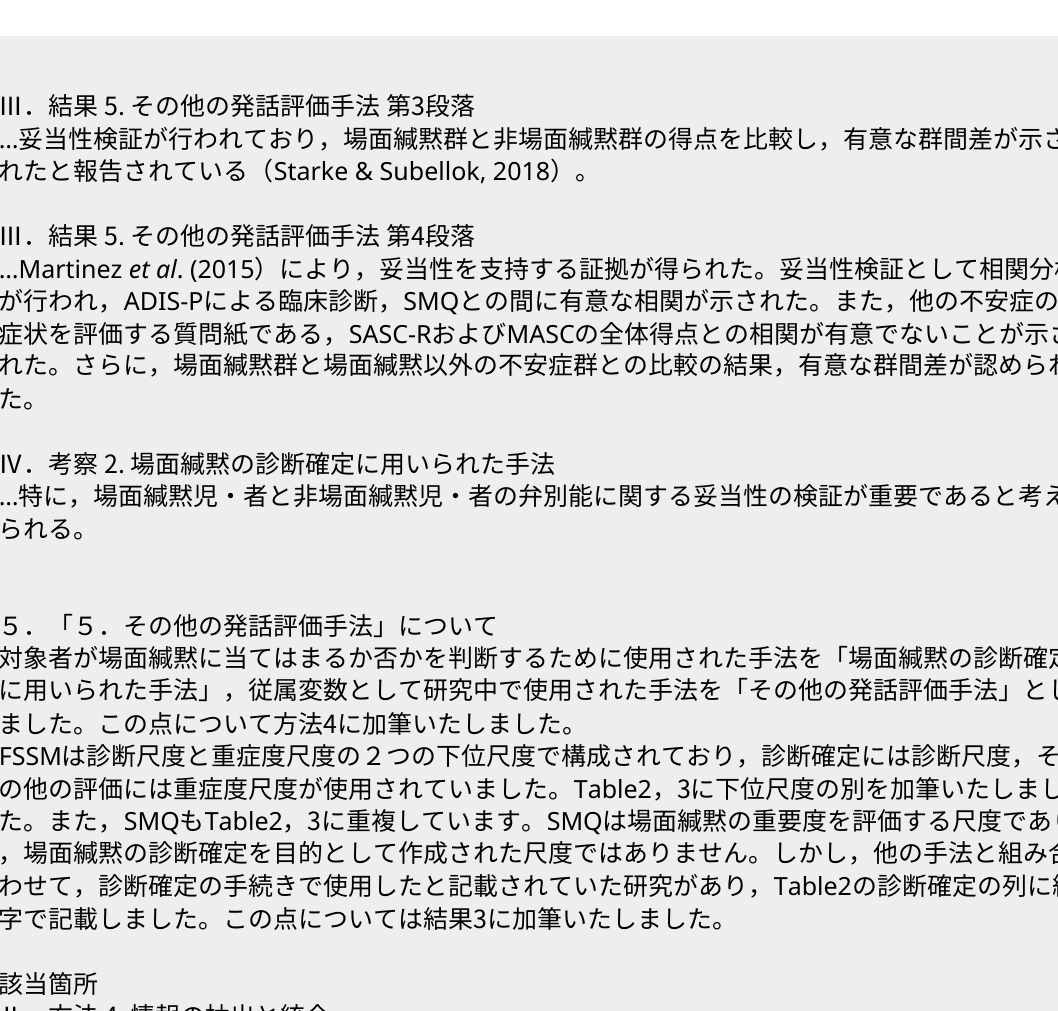
FSSM 診断尺度 Ⅲ．結果 3. 場⾯緘黙の診断確定に⽤いられた⼿法 第１段落